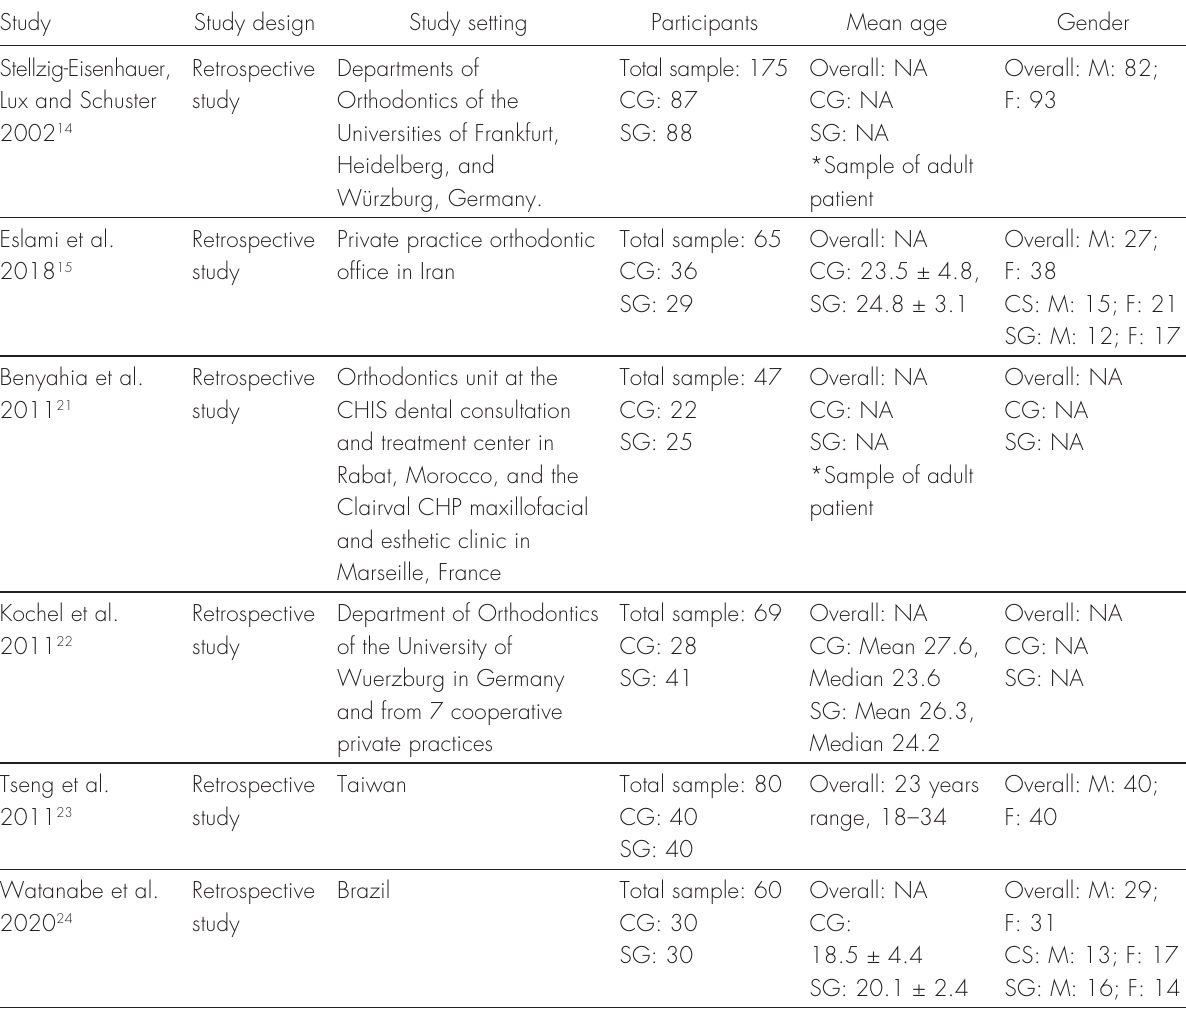
Table II. Characteristics of the included studies.